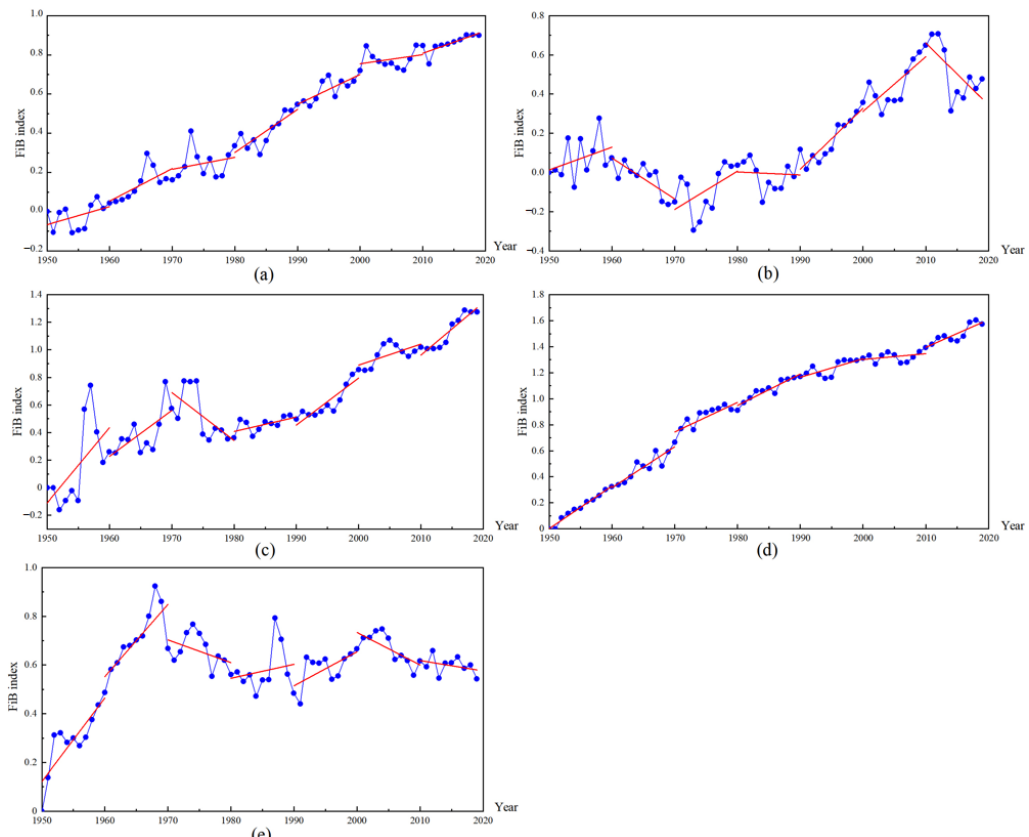
Figure 6. Trends of Fishing-in-Balance (FiB) index in Africa during 1950–2019: ( a ) North Africa; ( b ) East Africa; ( c ) Central Africa; ( d ) West Africa; ( e ) Southern Africa. Note: Red lines visualize the Slope, by decade. The results were calculated according to Formulas